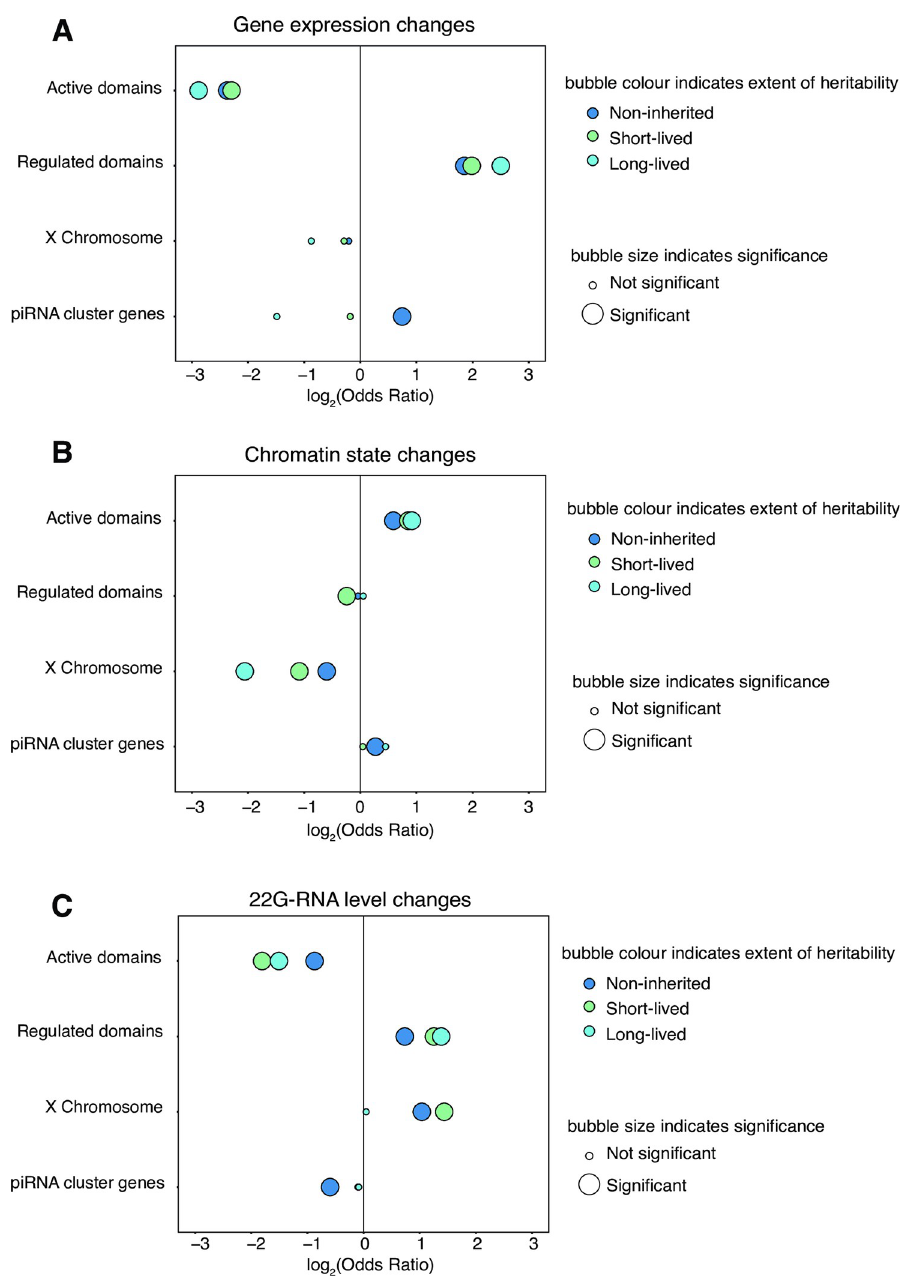
Fig 4. Enrichment of gene expression changes and epimutations in different constitutive chromatin domains. A. Bubble plot showing distribution of non-inherited (dark blue), short-lived (light green) and long-lived (light blue) gene expression changes in distinct chromatin domains. B. Bubble plot showing distribution of non-inherited, short-lived and long-lived chromatin-based epimutations in distinct chromatin domains. C. Bubble plot showing distribution of non-inherited, short-lived and long-lived 22G-RNA-based epimutations in distinct chromatin domains. For all plots, Y-axis shows constitutive chromatin domains investigated. X-axis shows log 2 (Odds) of enrichment. Odds ratios and p- values calculated with Fisher’s Exact Test with Bonferroni correction. p-value cut off for significance is 0.1.